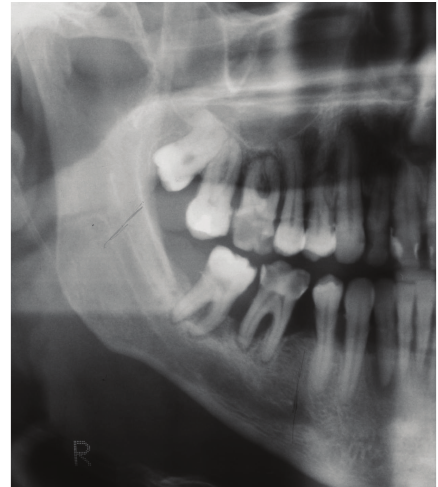
Figure 9: Case 3—preoperative OPTG. Beside multiple carious lesions the present X-ray examination reveals signs of chronic periodontal disease with a general loss of horizontal bone level, liberationofbothdentalroots,andbifurcations.Thelocalmaximum of destruction is found in the region of the last two molars. The retromolar triangle, however, appears to be intact.